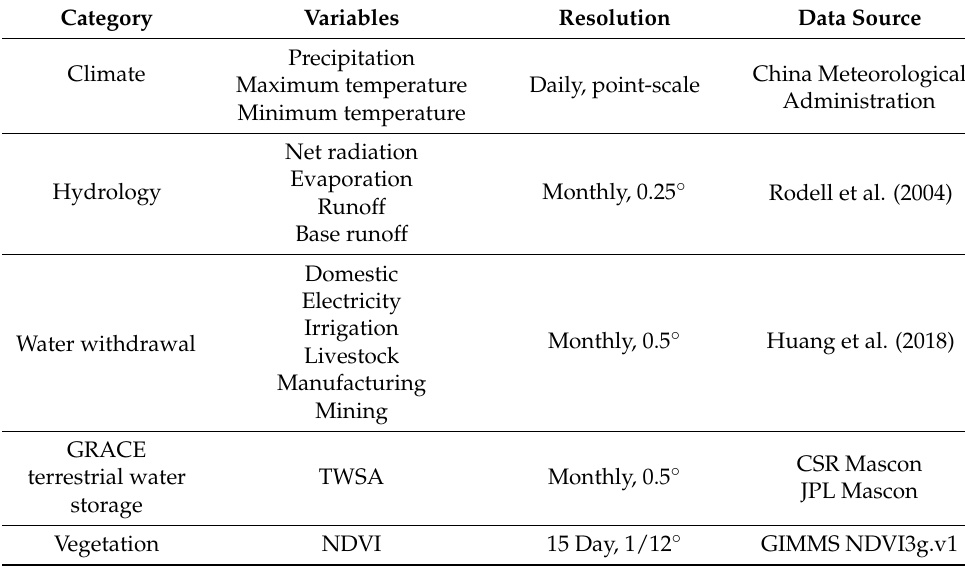
Table 1. Summary of the datasets used in this